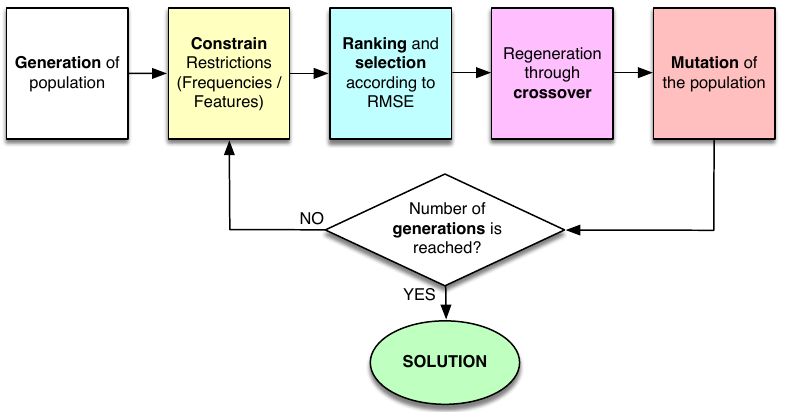
Figure 9. Scheme of the evolutionary algorithm applied in the